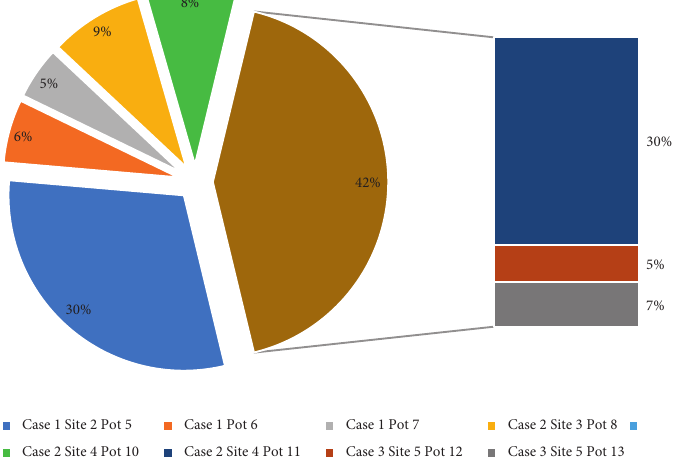
Figure 2: The distribution of the proportion of the sports industry evaluation